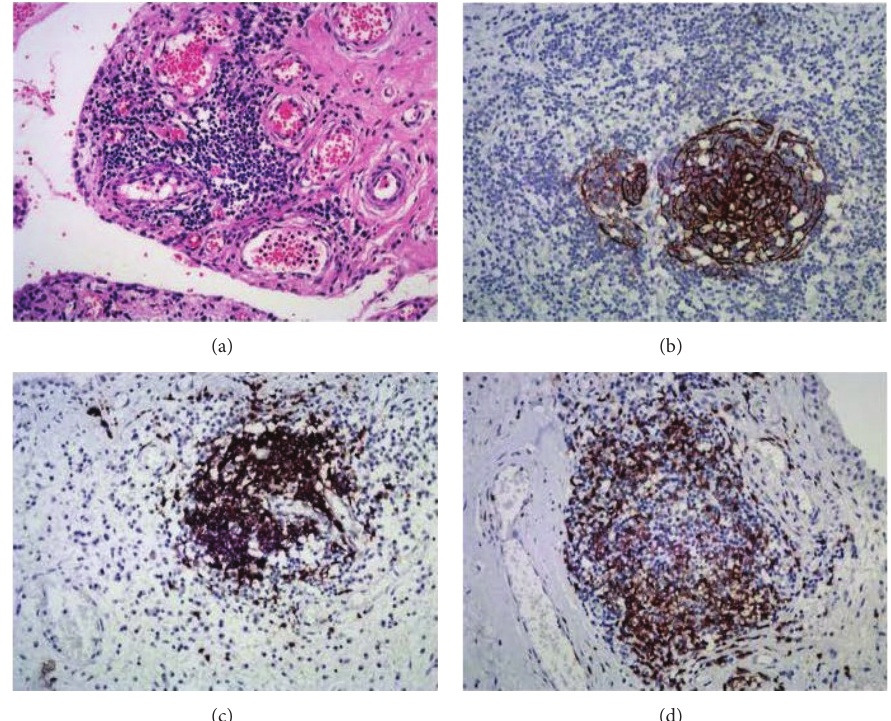
Figure 2: Histologic findings and expression of CD molecules in case 5. (a) Staining with hematoxylin and eosin [H&E]. (b) CD21-positive FDC networks (DAB staining, 200x); (c) numerous CD20 positive B-cells in lymphoid neogenesis (DAB staining, 200x); and (d) Numerous CD3 positive T-cells in lymphoid neogenesis (DAB staining,